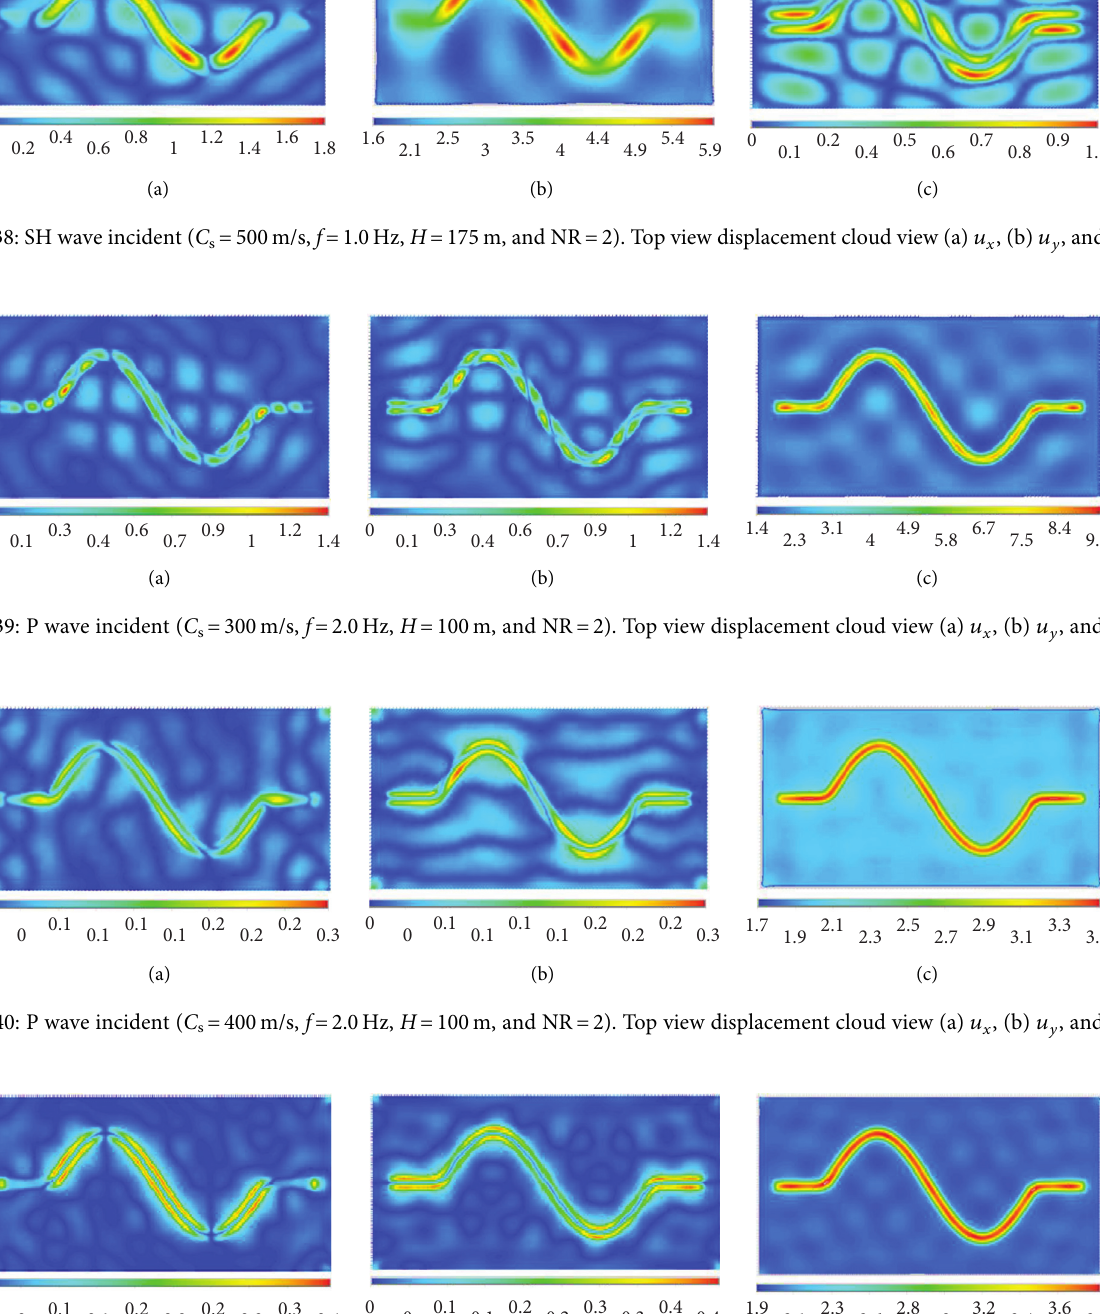
� 500m/s, f � 2.0Hz, H � 100m, and NR � 2). Top view displacement cloud view (a) u s